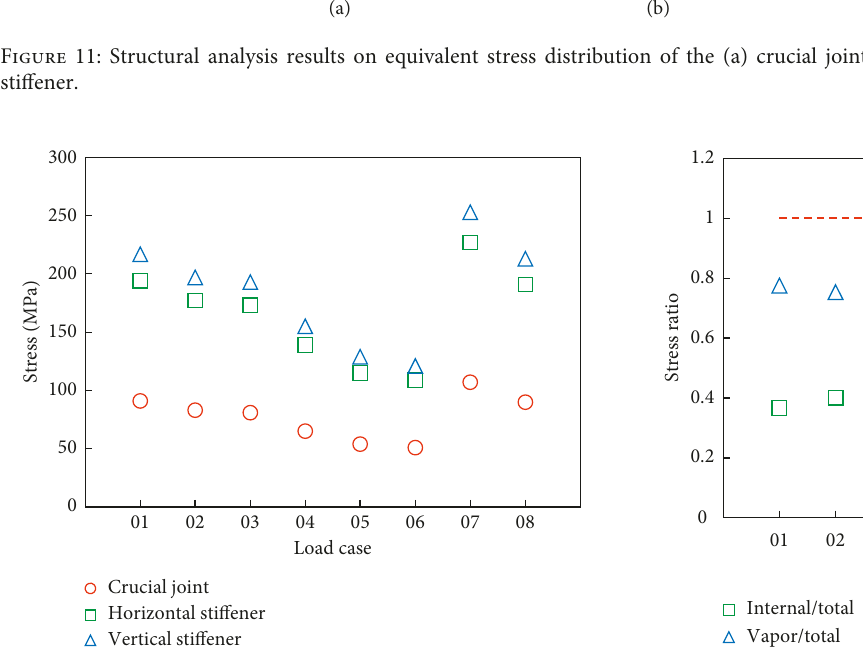
Figure 12: Comparison of equivalent stress at the typical structural joint for each load case.